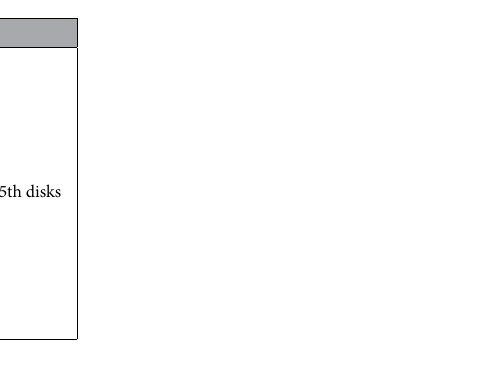
Table 3. Various levels of the radial